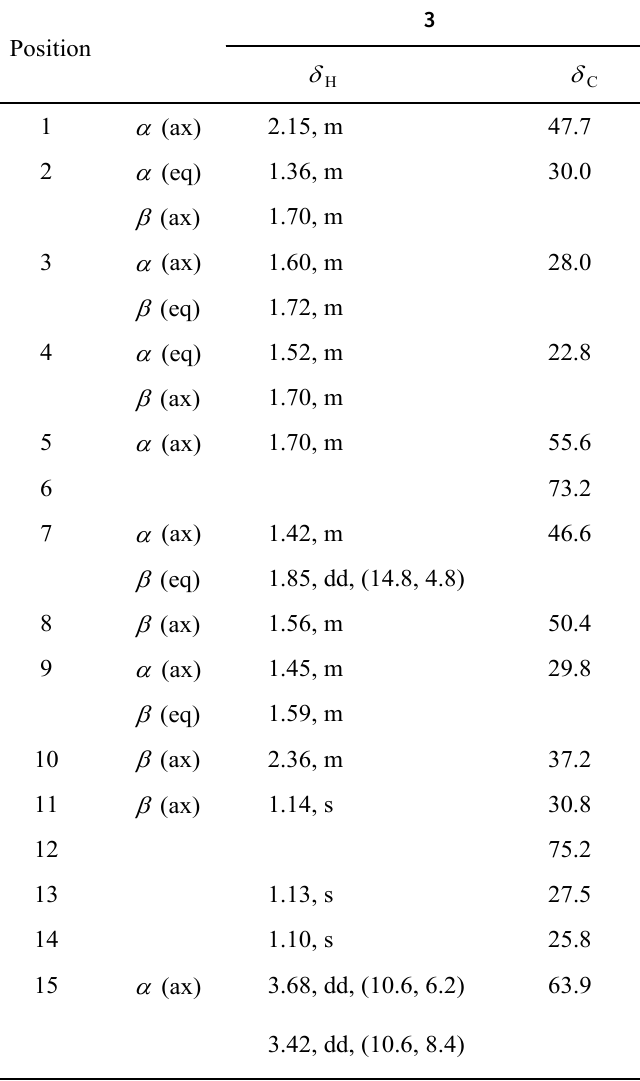
OD) of 1 . δ in ppm, J in 3